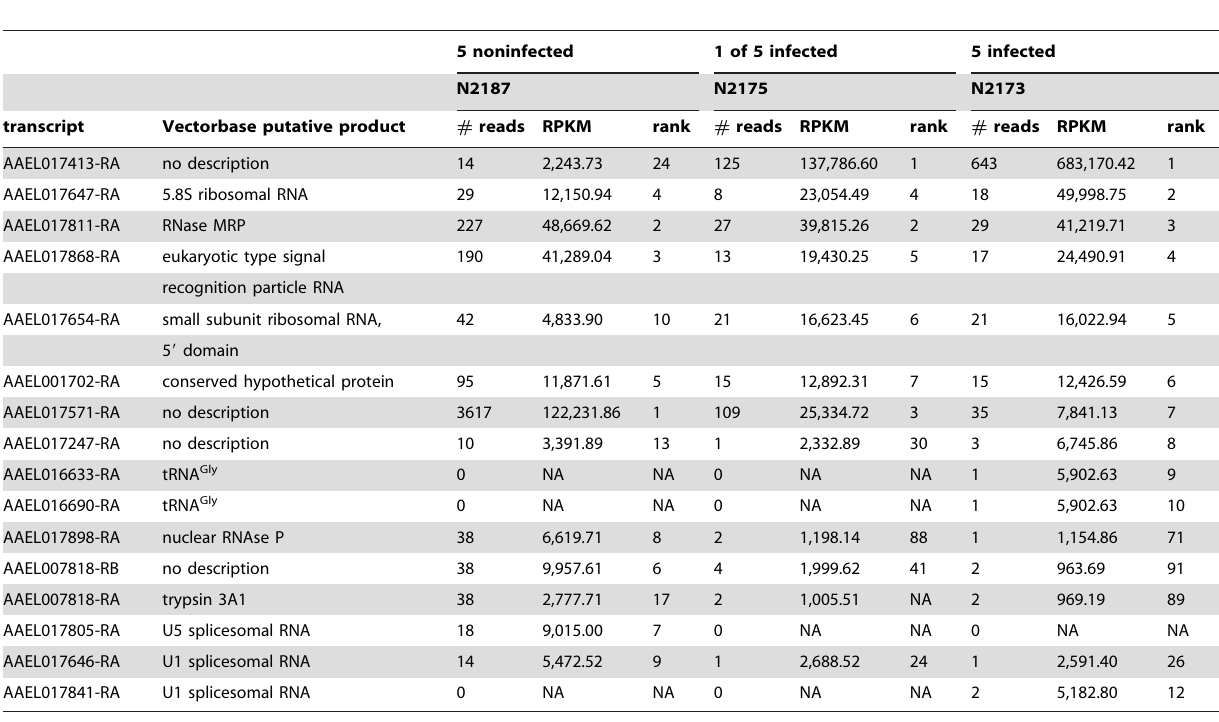
Table 3. Selected transcript profiles in DENV-1 infected and noninfected